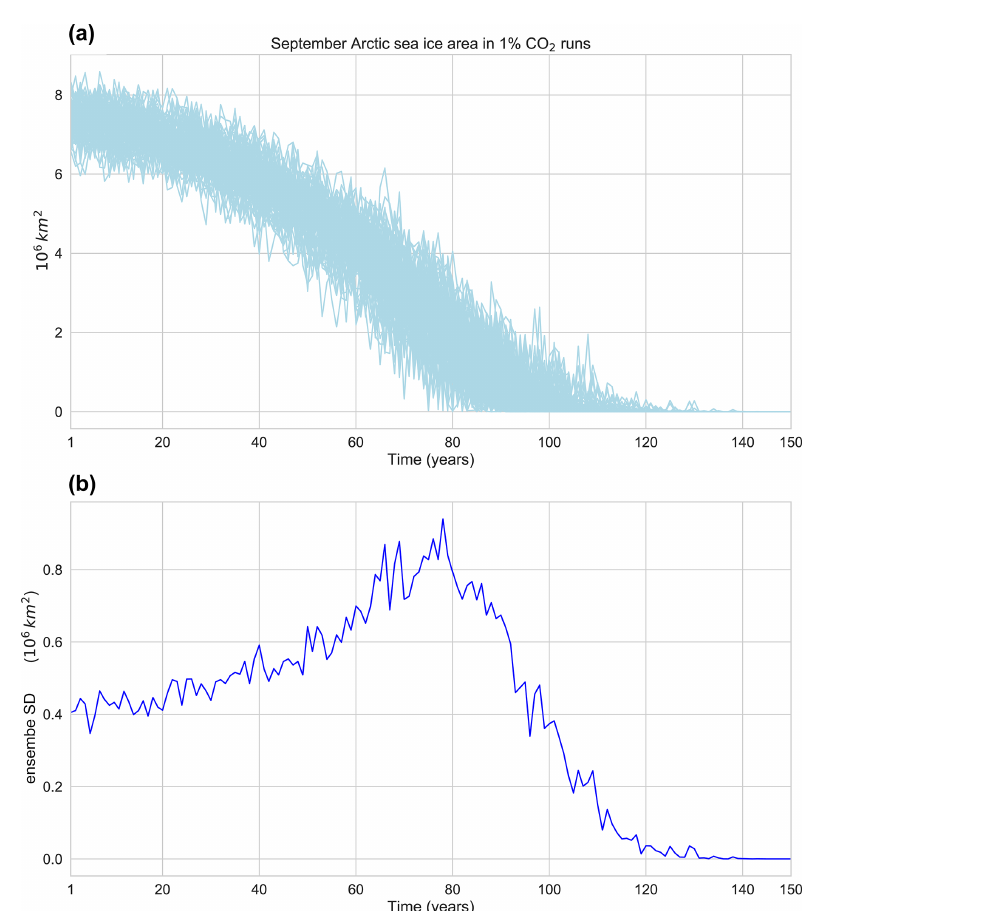
Figure B1. (a) September Arctic sea ice area in the 100 realisations for the 1% CO 2 experiment. (b) Ensemble standard deviation for the 100